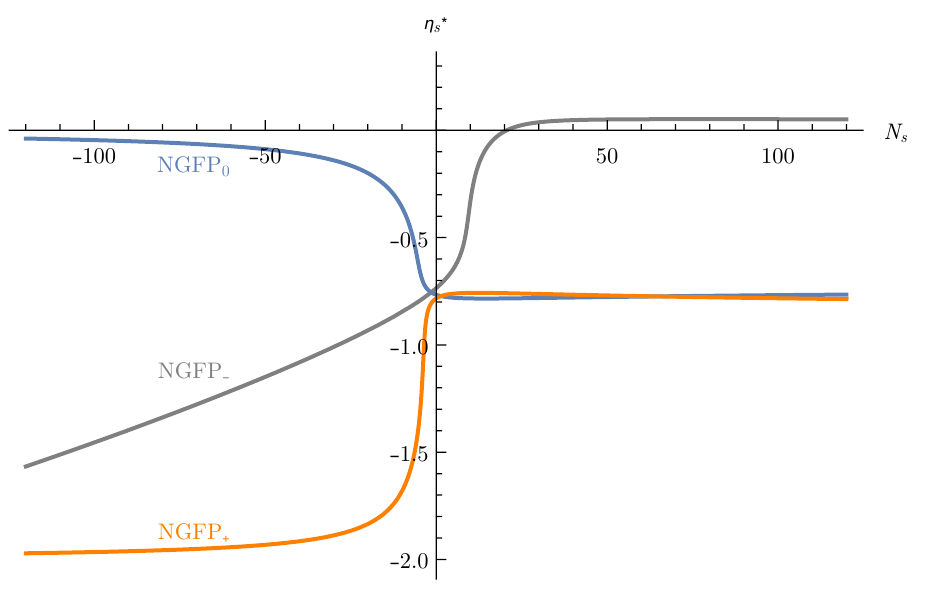
Figure 6 . Fixed point value of the scalar anomalous dimension (cid:17) (cid:3) of (cid:12)xed points NGFP (cid:0) , NGFP 0 , and NGFP + as a function of N s .